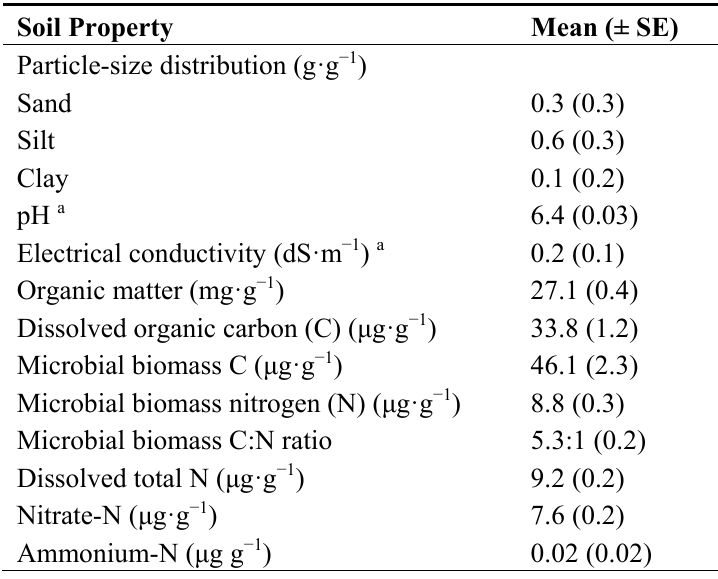
Table 2. Mean (± standard error (SE)) soil properties for the Razort silt loam prior to treatment ( n =